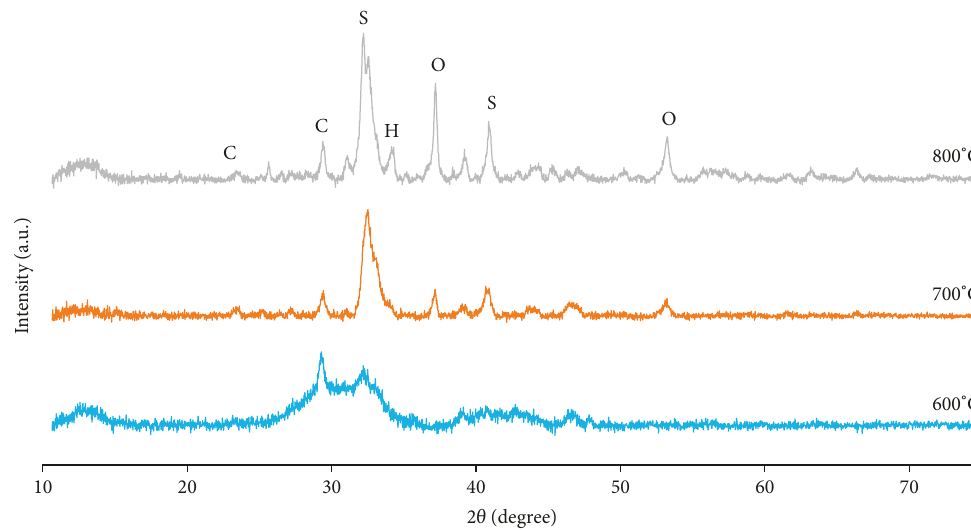
Figure 3: XRD patterns of the 3DOM CaO/SiO 2 . H (cid:31) Ca(OH) 2 , O (cid:31) CaO, S (cid:31) Ca 2 SiO 4 , and C (cid:31) CaCO 3 .